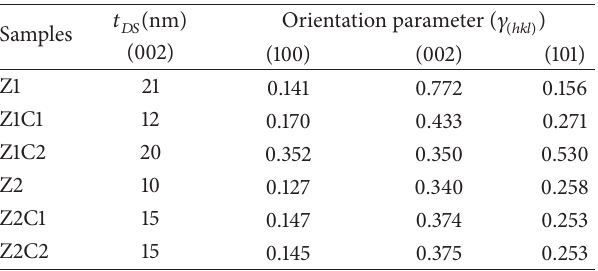
Table 1: Crystallite size ( 𝑡 𝐷𝑆 ) and orientation parameter ( 𝛾 ) of all the samples.